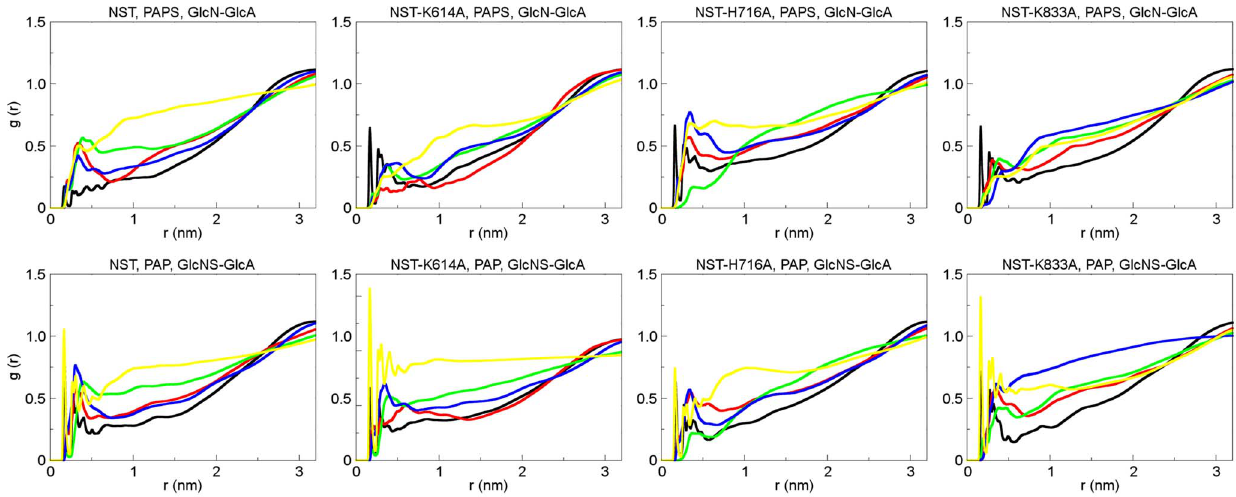
Figure 7. Radial distribution functions. g(r), centered on the side chain atoms of the residues involved in sulfate transfer to the oxygen atoms of modeled water of the eight complexes: Black, Sulfonate O c solvation; red, Lys614 N c solvation; green, His716 NH t solvation, blue, Lys833 N c solvation; yellow, glycan NH2 solvation.